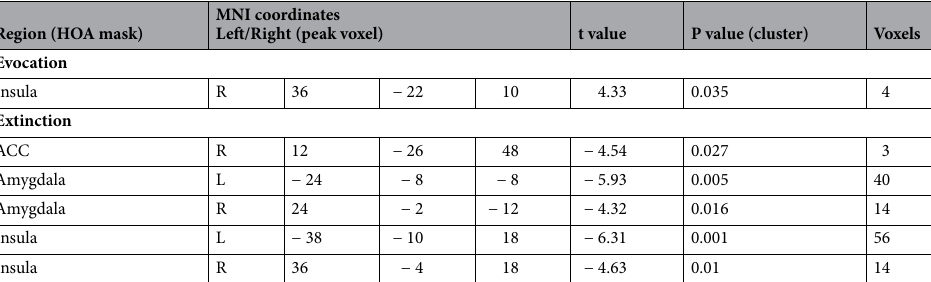
Table 3. Results of exploratory ROI analyses for evocation (first 10 extinction trials) nocebo > control, and extinction (remaining 18 extinction trials) nocebo > control contrasts. Coordinates given in x, y, z for